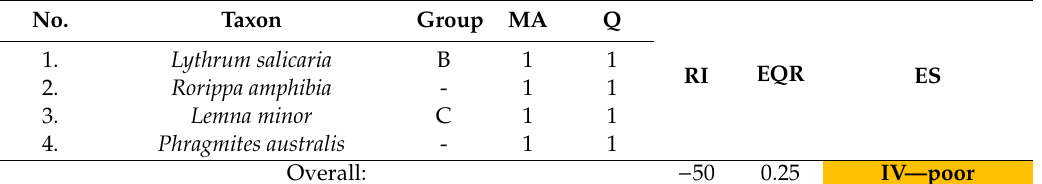
Table 17. Summary of RI-BG results, May 2017, section above the SHP on the